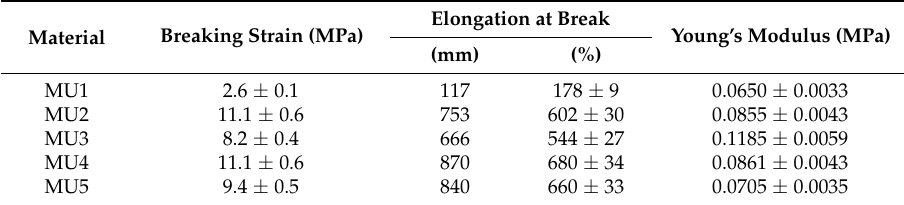
Table 6. Summary of mechanical properties of the composites.